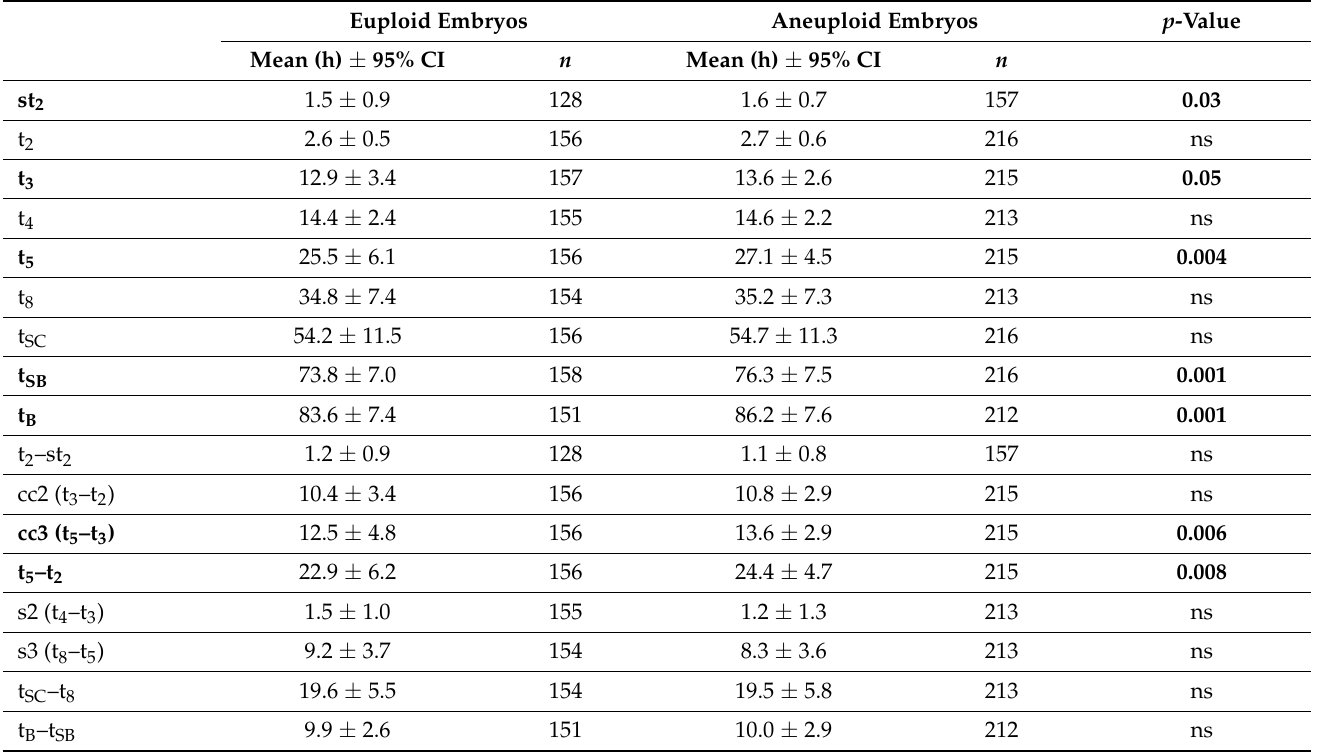
Table 1. Annotations for morphokinetic parameters were analyzed using time-lapse technology. Euploid Embryos Aneuploid Embryos p